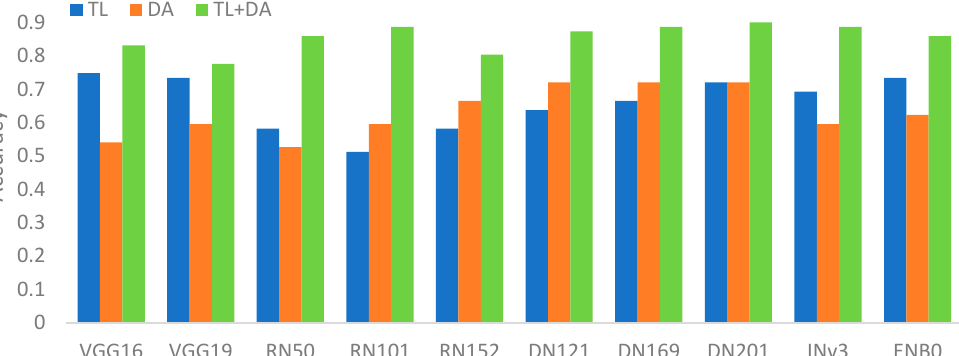
Figure 11. Accuracies of compared CNNs by considering transfer learning (termed TL), data augmentation (termed DA), and fusion of TL and DA (termed TL+DA).